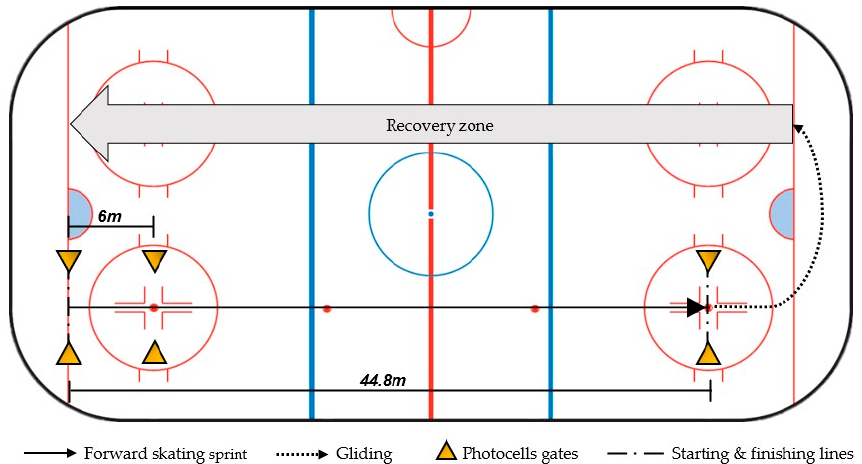
Figure 2. The 44.8-m skating sprint test.